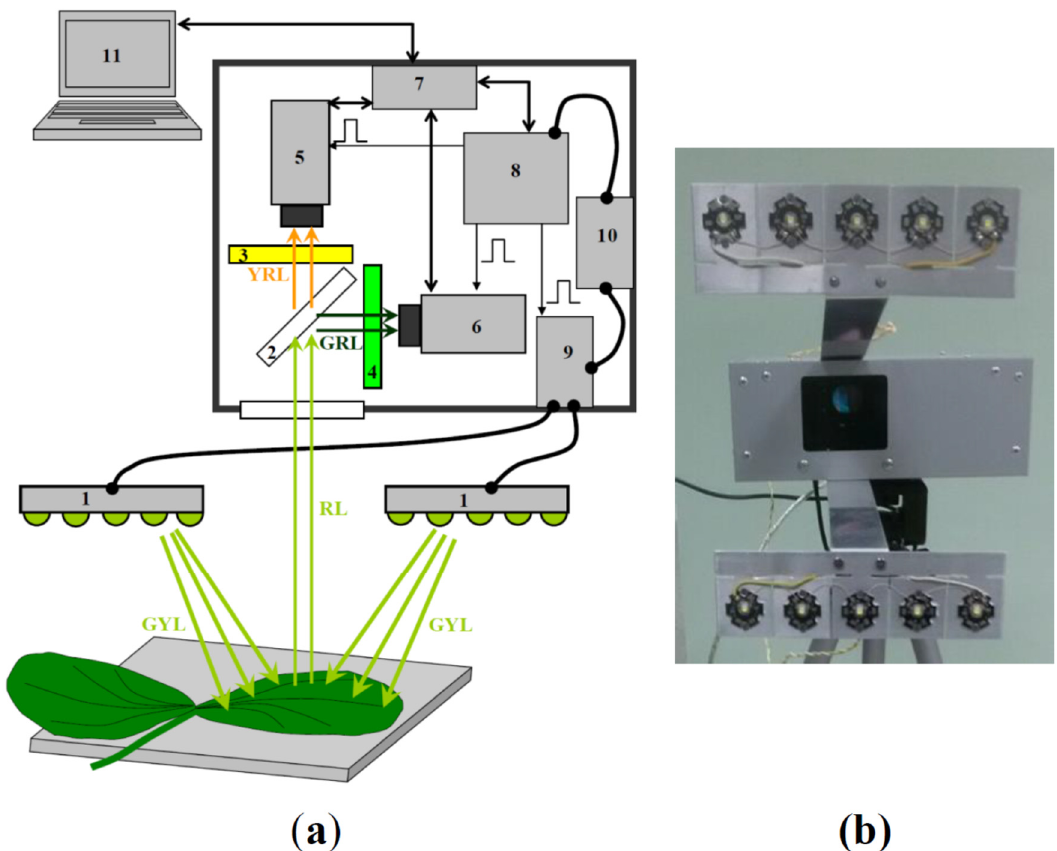
Figure 1. The schema ( a ) and photo ( b ) of the developed system for photochemical reflectance measurements. The system includes light-emitting diodes (LEDs) (1), beamsplitter (2), bandpass filters for yellow (3) and green (4) light CCD cameras with objective lenses (5, 6), USB hub (7), ARDUINO UNO (8), LEDs current source (9), power supply (10), and a laptop (11). GYL is the green-yellow measuring light. RL is the reflected light. GRL and YRL are green and yellow RLs, respec- tively.